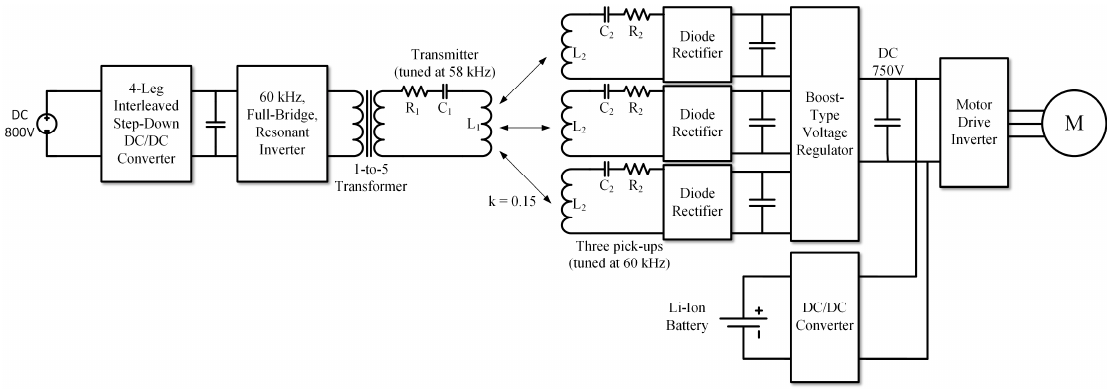
Figure 9. Equivalent block diagram of the developed test-bed.